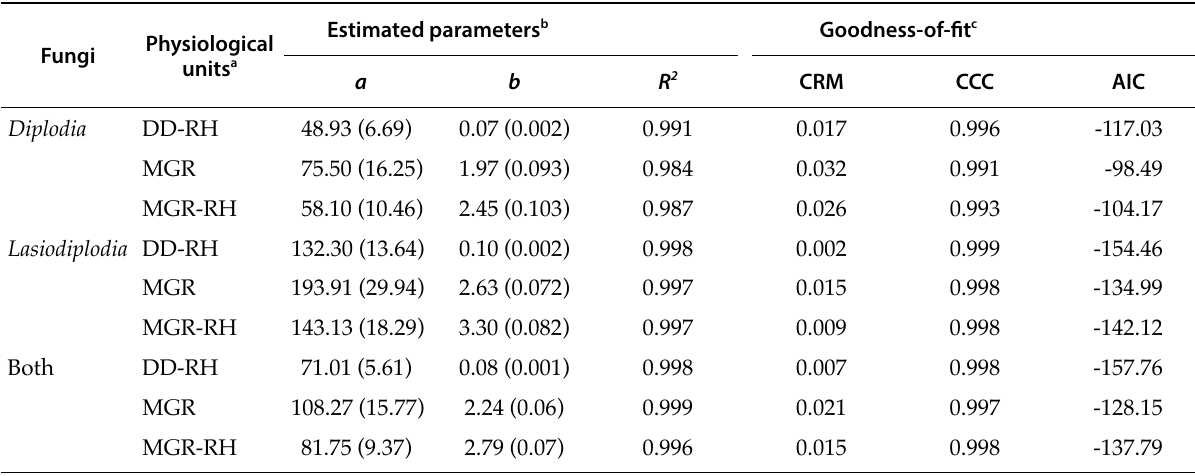
Table 2. Parameters and goodness-of-fit statistics of the equations used to describe the effects of different physiological units on the cumulative numbers of Botryosphaeriaceae conidia sampled from symptomatic grapevine plants or pruning debris, in four vineyards in St Vicente Ferrer (Brazil) between August 2016 and October